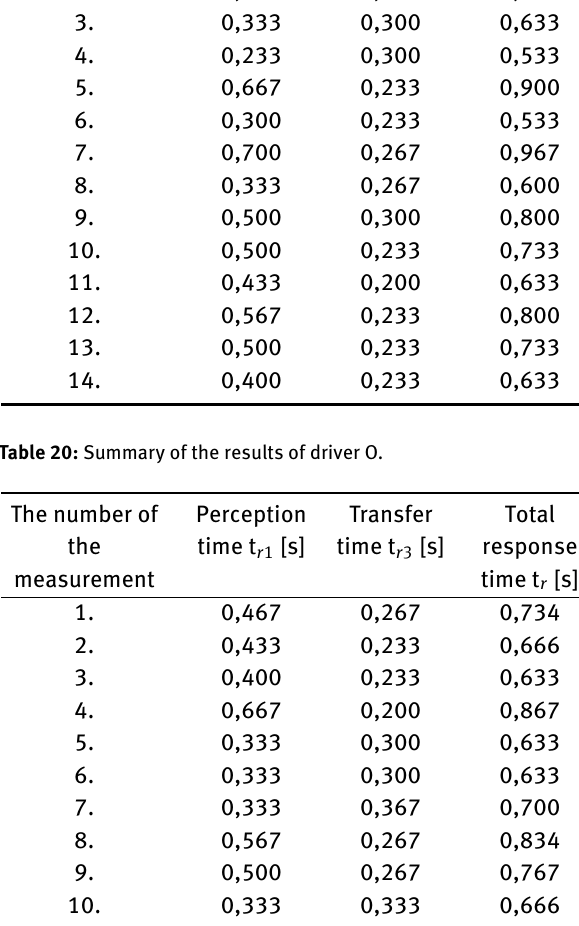
Table 19: Summary of the results of driver N. The number of the measurement